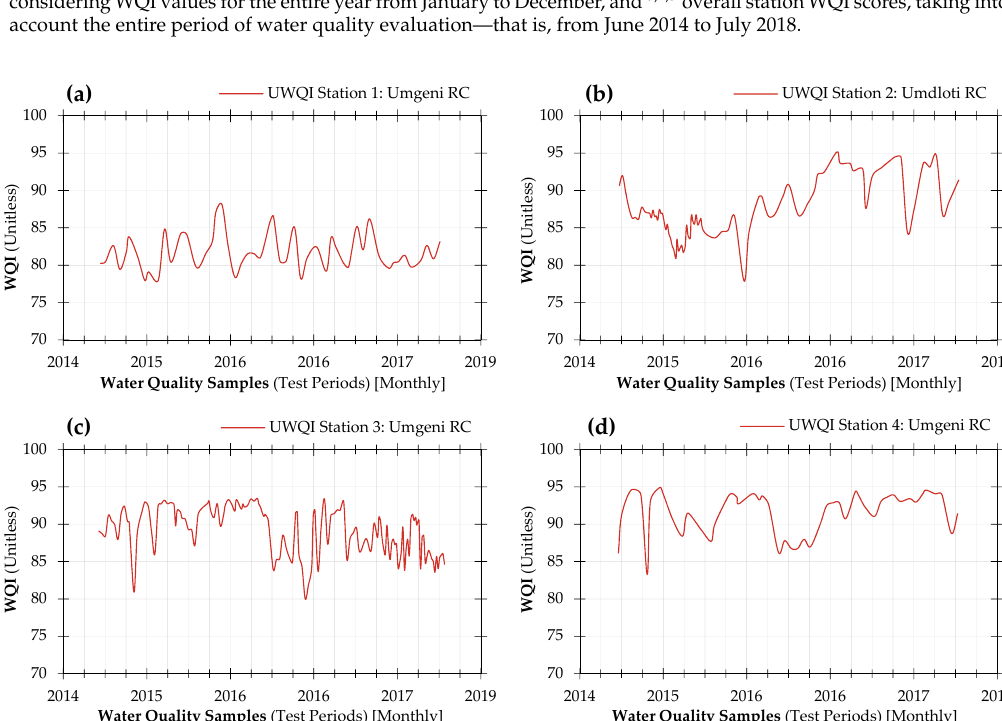
Table 6. Calculation of water quality index scores using universal water quality index (UWQI) model. Calculation of WQI using the Parameter Values Corresponding to the Key Points of the Rating Curves Key Water Quality Parameters c Point a